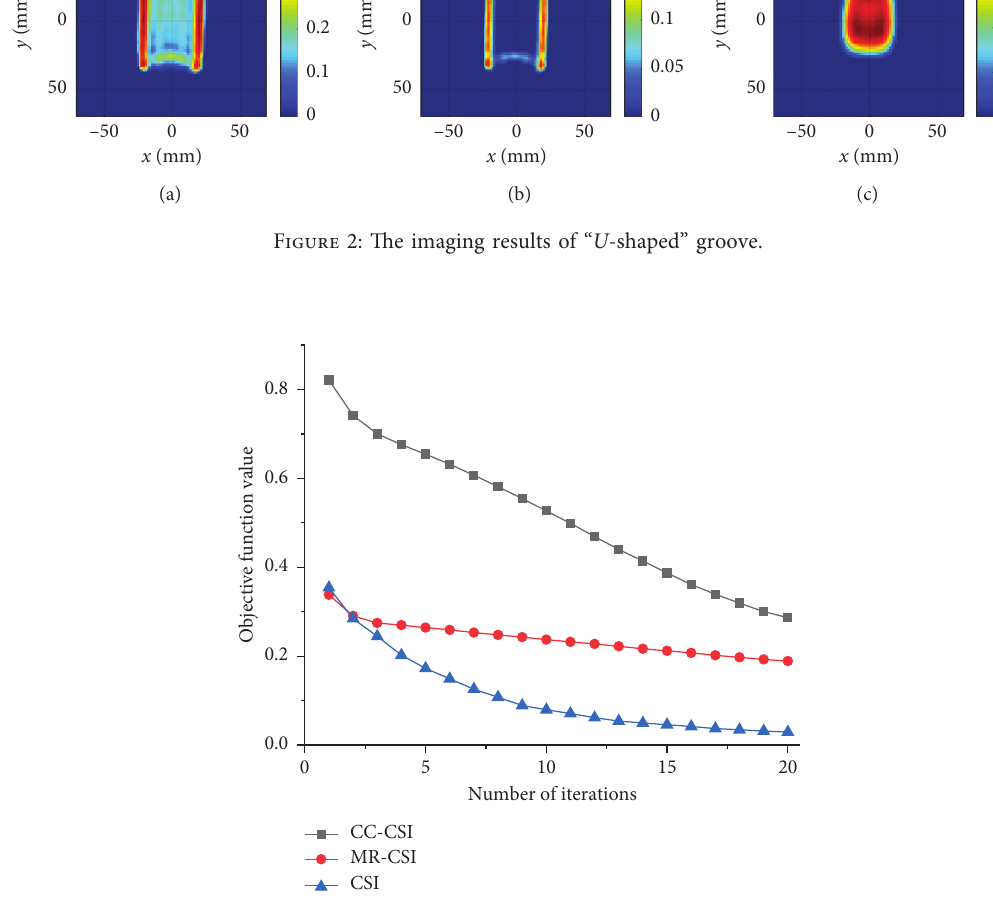
Figure 3: The objective function values of “ U -shaped” groove.